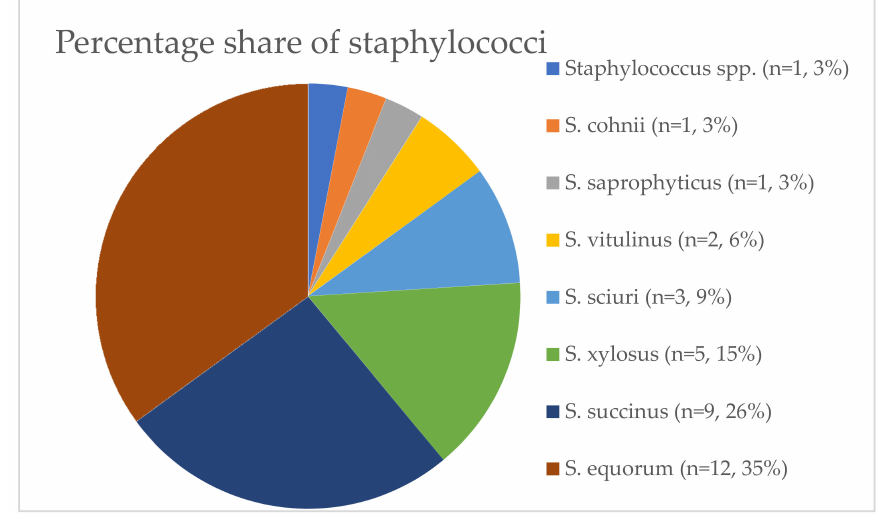
Figure 7. Share (%) of identified staphylococci isolated from the examined